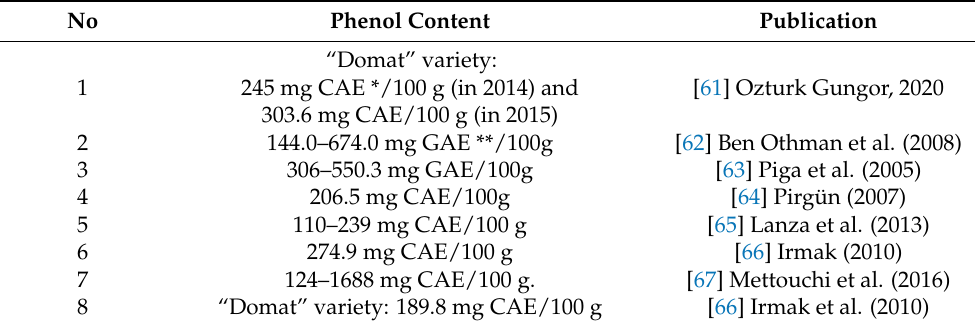
Table 6. Recently published results of phenol contents in raw olive fruits (expressed on a fresh weight